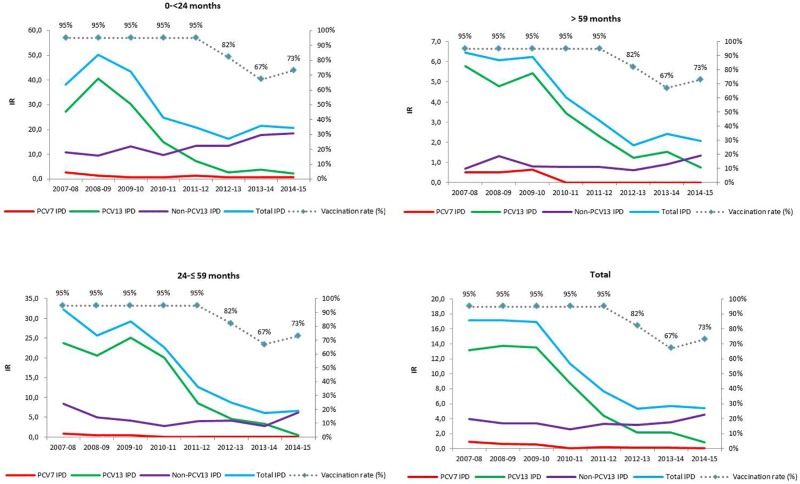
Incidence rates.Incidence rate (IR) of invasive pneumococcal disease in total (all children <15 years old) and in the different age groups. Percentages of vaccine coverage are shown as dotted lines. Data from 2007 to 2012 have been previously reported (references 13–17).